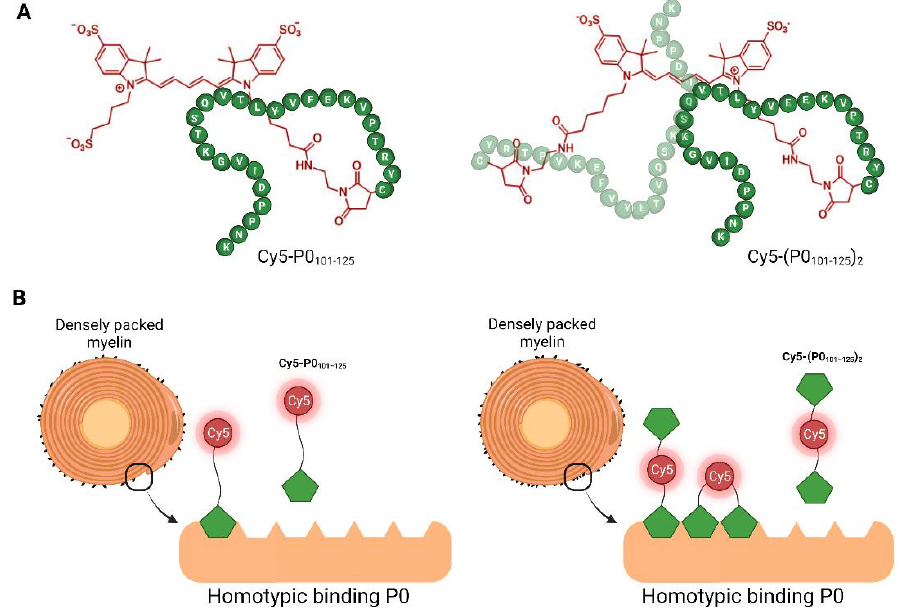
Figure 1. ( A ) Schematic structure of mono-labeled Cy5-P0 101–125 and bi-labeled Cy5-(P0 101–125 ) 2 agents; ( B ) dimerization effect on binding affinity of Cy5-P0 101–125 (left) and Cy5-(P0 101–125 ) 2 (right) to Schwann cells.